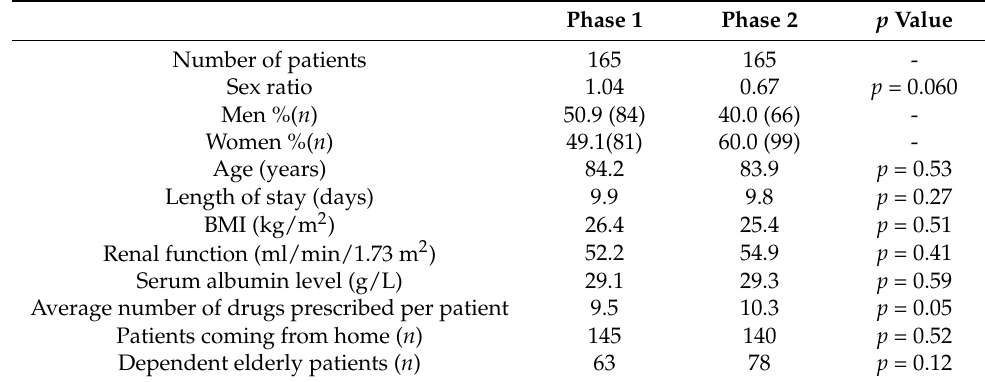
Table 3. Demographic and clinical data of patients included in the two audit